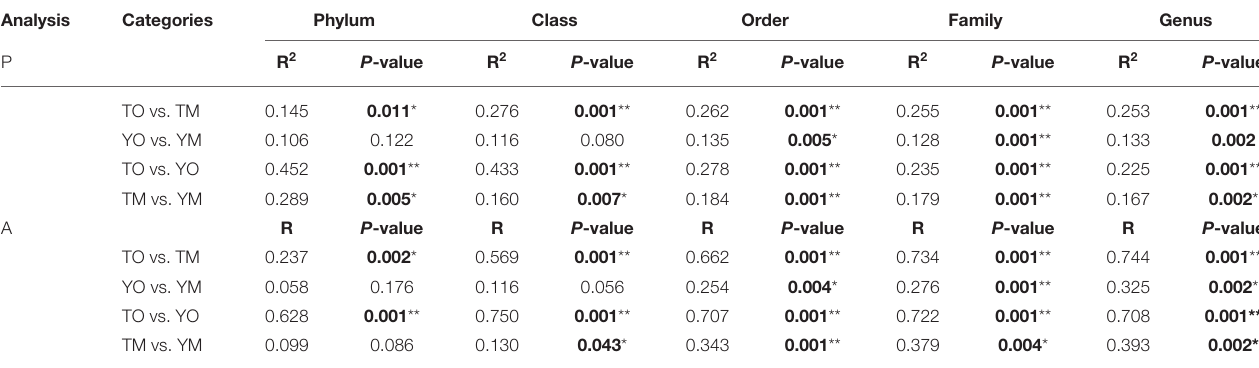
* P < 0.05, ** P ≤ 0.001. The bold values mean significant